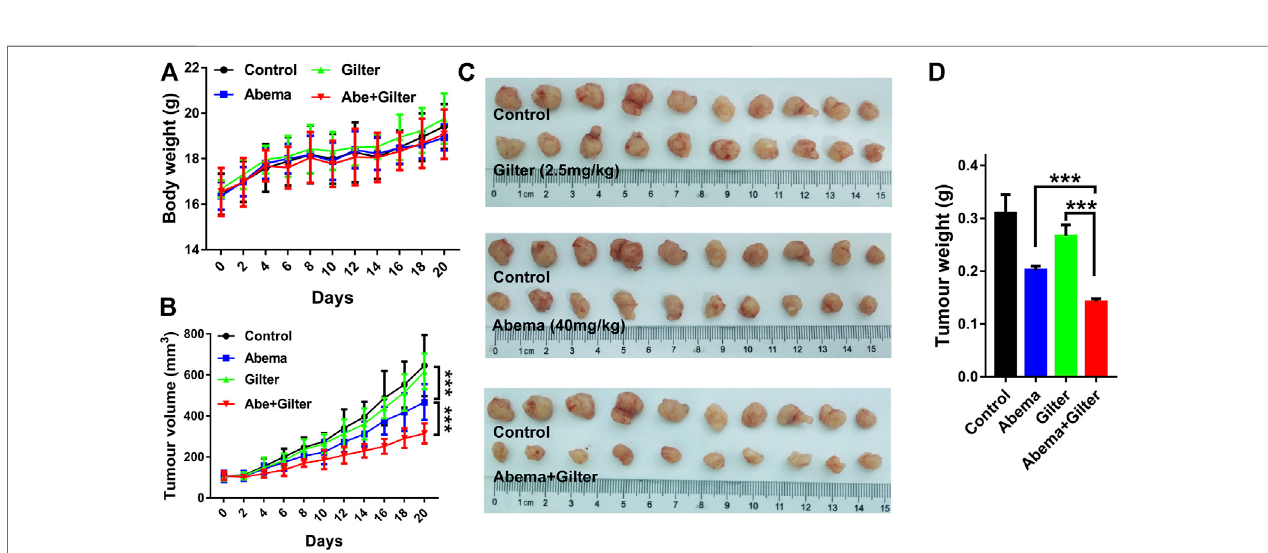
FIGURE7| Abemaciclib incombinationwithgilteritinib suppresseslungcancergrowth invivo .A549cells(4×10 6 )weresubcutaneouslyinjected intoBALB/c nude mice.Whentumorsvolumereachedat100 mm 3 ,micewererandomlydividedintofourgroups:control,abemaciclib(40 mg/kg),gilteritinib(2.5 mg/kg),abemaciclibplus gilteritinib ( n = 10). Mice in treatment groups were administered daily via oral gavage, while mice in control group were treated with vehicle for continuous 20 days (A,B) Body weight and tumor volume were measured at every 2 days (C) After treatment, tumor tissues were collected, and the tumor inhibitory rate was calculated (D) The tumor weight was measured. *** p <